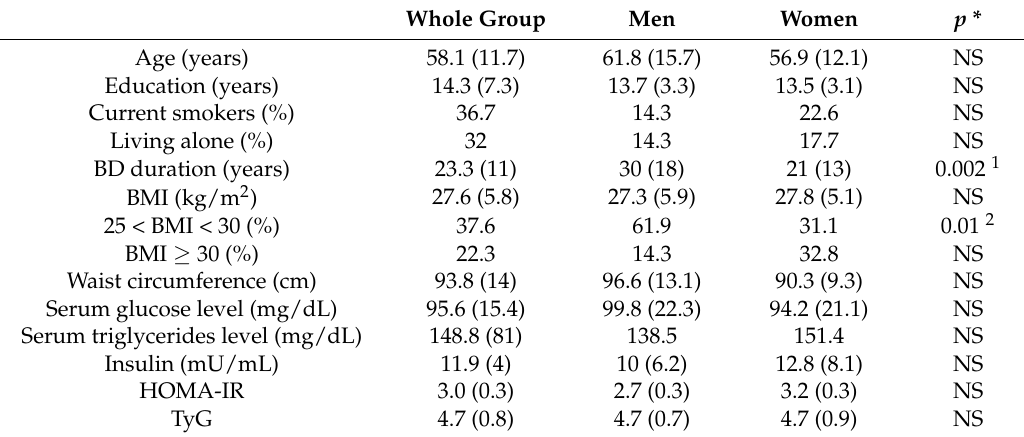
Table 1. Demographic, clinical, anthropometric characteristics and laboratory tests results of euthymic bipolar patients. The results are presented as mean and standard deviation (SD) or percentage. Whole Group Men Women p